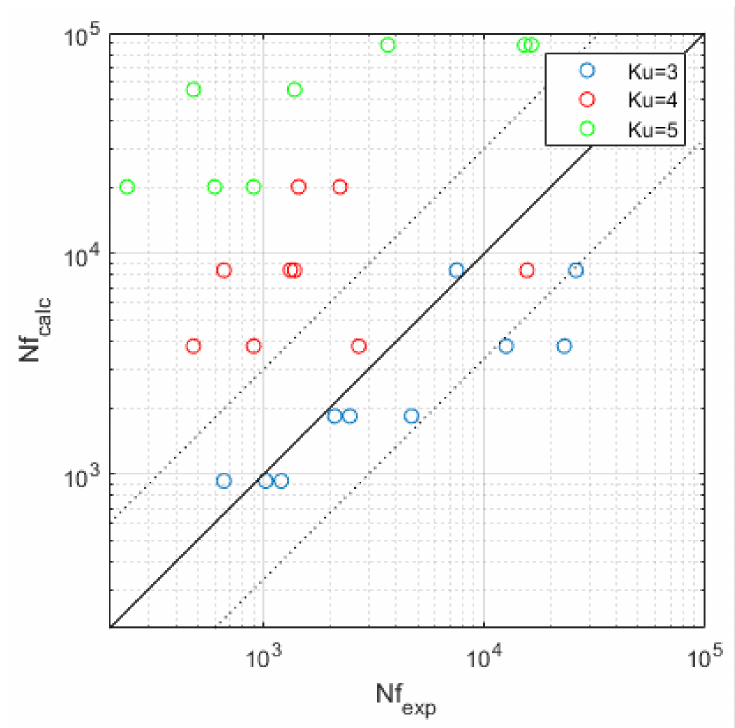
Figure 6. Comparison of experimental and predicted fatigue